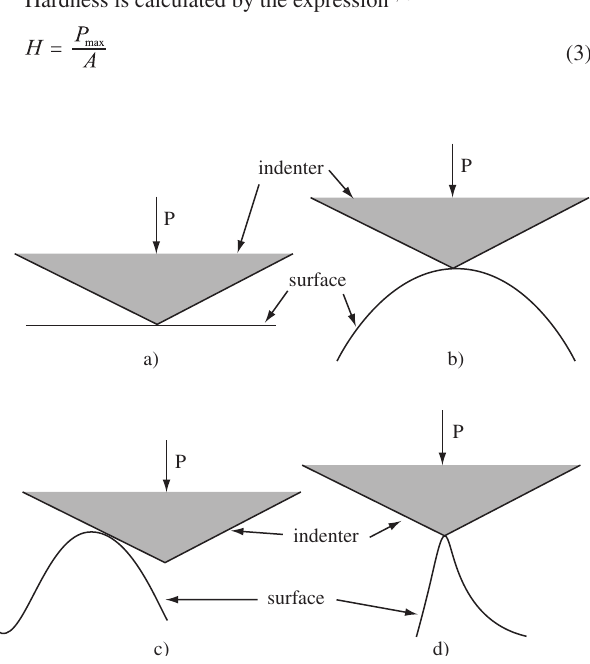
Figure 3. Different tip-surface approach. a) No asperities present (flat sur- face); b) asperities larger than tip diameter; c) tip sliding at the asperity; and d) asperity curvature diameter in the same order than tip